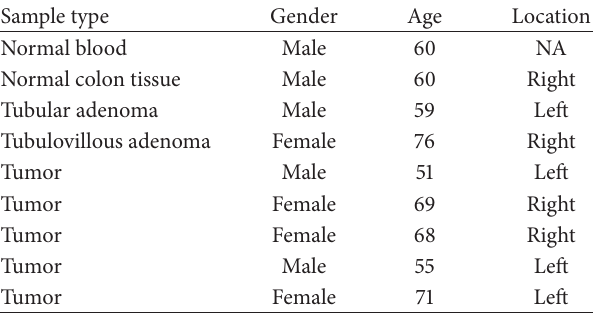
Table 1: Demographical characteristics of the analyzed